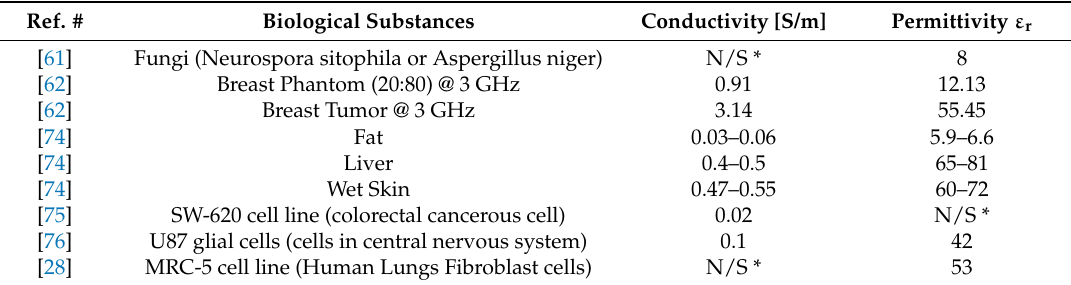
Table 3. The conductivity and permittivity of biological